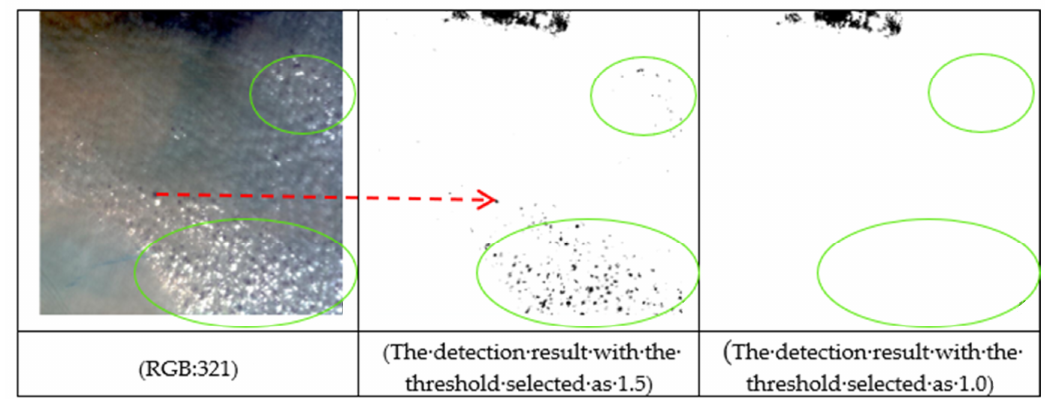
Figure 5. Comparison of results of different thresholds. The tail of the red arrow is the thin clouds in the image (Bands 3, 2, and 1 composite), and the head is the recognition of the corresponding part of the tail after the threshold of the ratio of the blue band to the red edge 1 band is increased to 1.5. The green circled is the recognition of thin clouds because of the different thresholds.